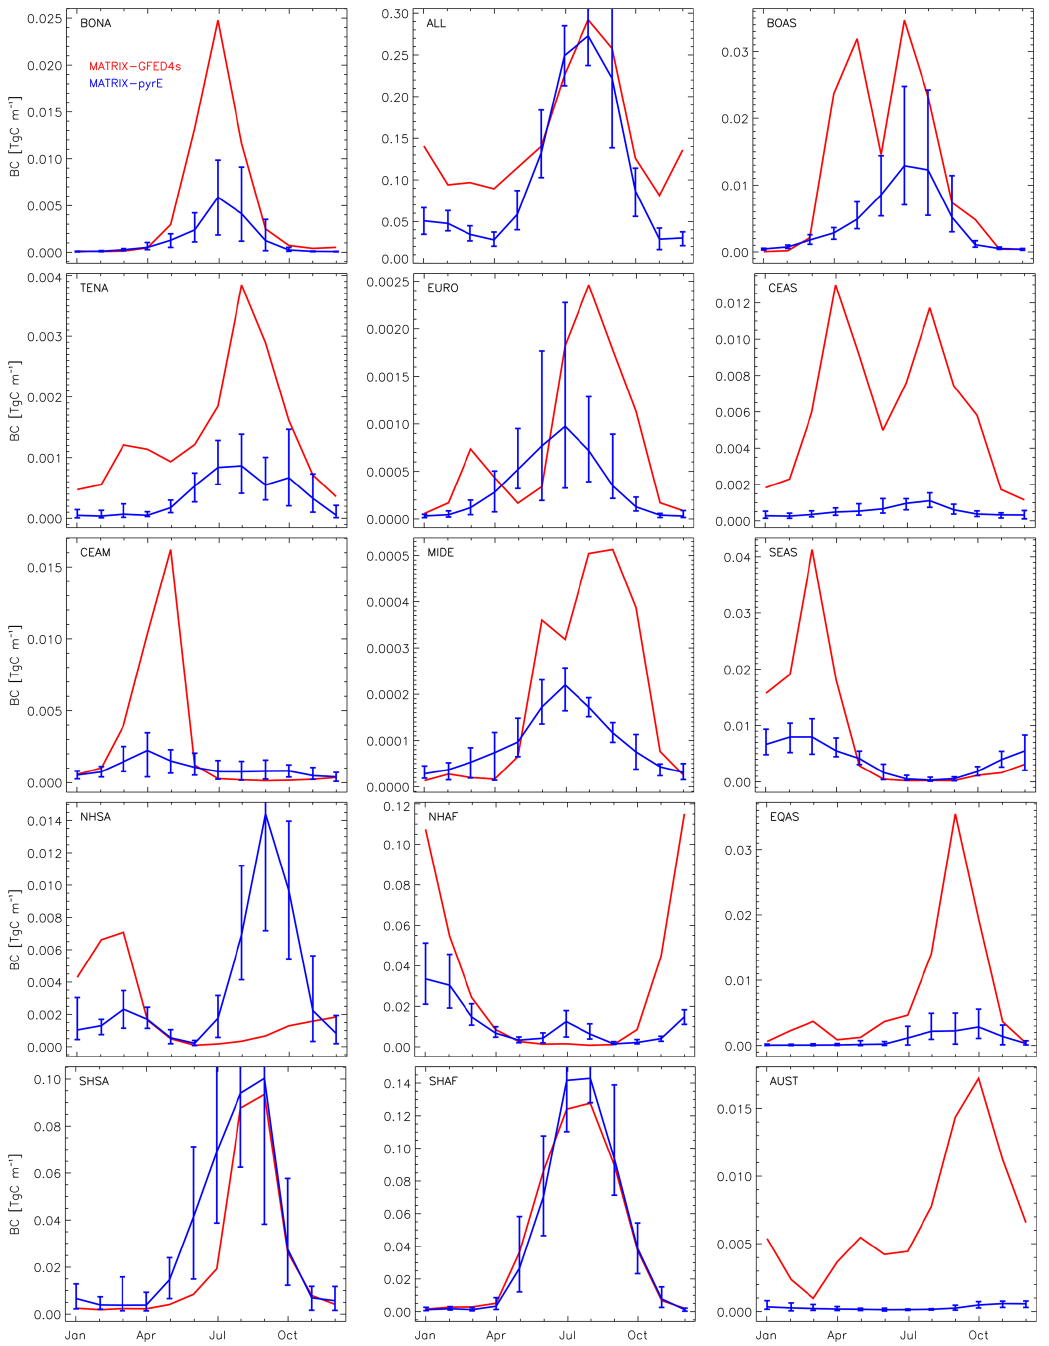
Figure A5. Seasonality of total fire BC emissions simulated (blue) and reported by GFED4s (red) in all GFED regions. Error bars represent the 10-year range in the simulations. Note the different scales in each